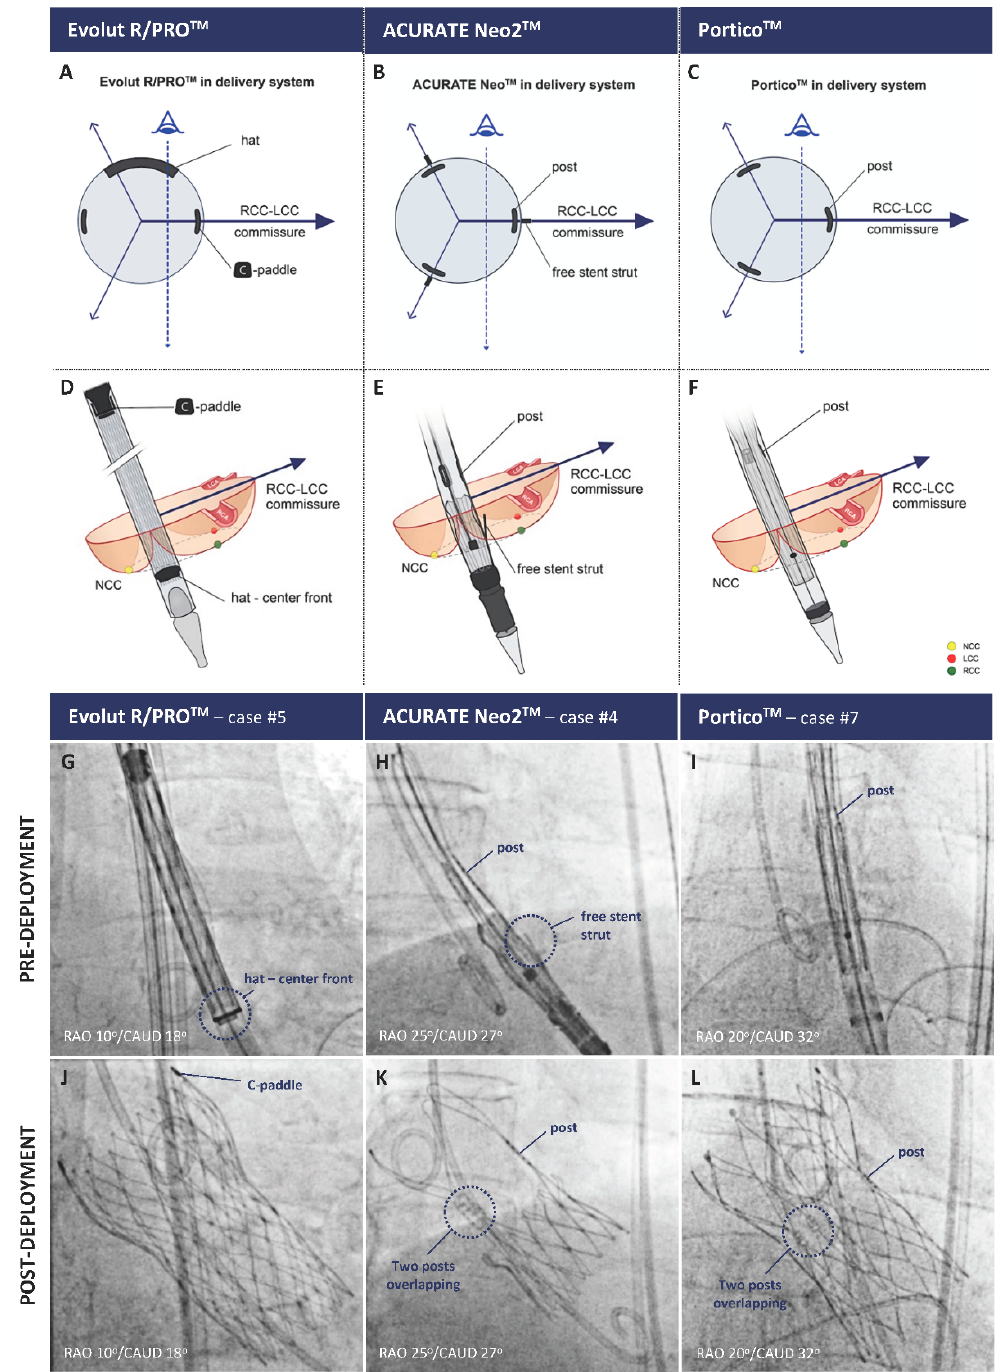
Figure 2. Positioning of the radiopaque THV commissural markers to obtain neo-commissural alignment using the RCC/LCC cusp overlap view for the Evolut R/PRO+ ( left column ), ACURATE neo2 ( middle column ), and Navitor platforms ( right column ). Panels ( A – C ), radiopaque marker orientation in a transversal plane; Panels ( D – F ), schematics of radiopaque marker positioning on fluoroscopy; Panels ( G – L ), fluoroscopic images before and after THV deployment, respectively. THV = transcatheter heart valve. LCC = left coronary cusp. NCC = non-coronary cusp. RCC = right coronary cusp. Reprinted from Bieliauskas et al.